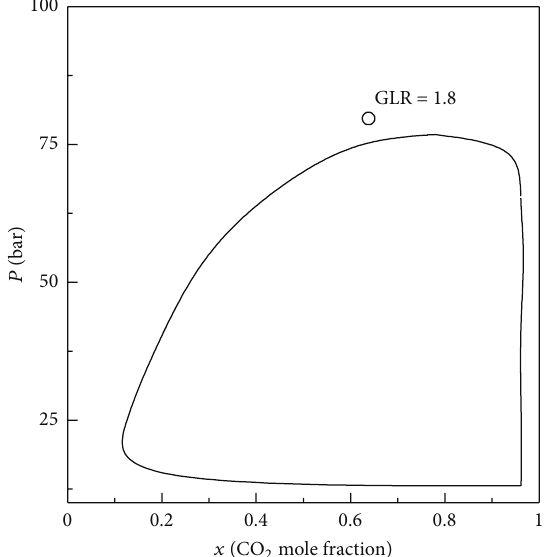
Figure 2: Vapor liquid equilibria for the system ethanol-CO 2 at 40 ∘ C. Adapted from Knez et al.